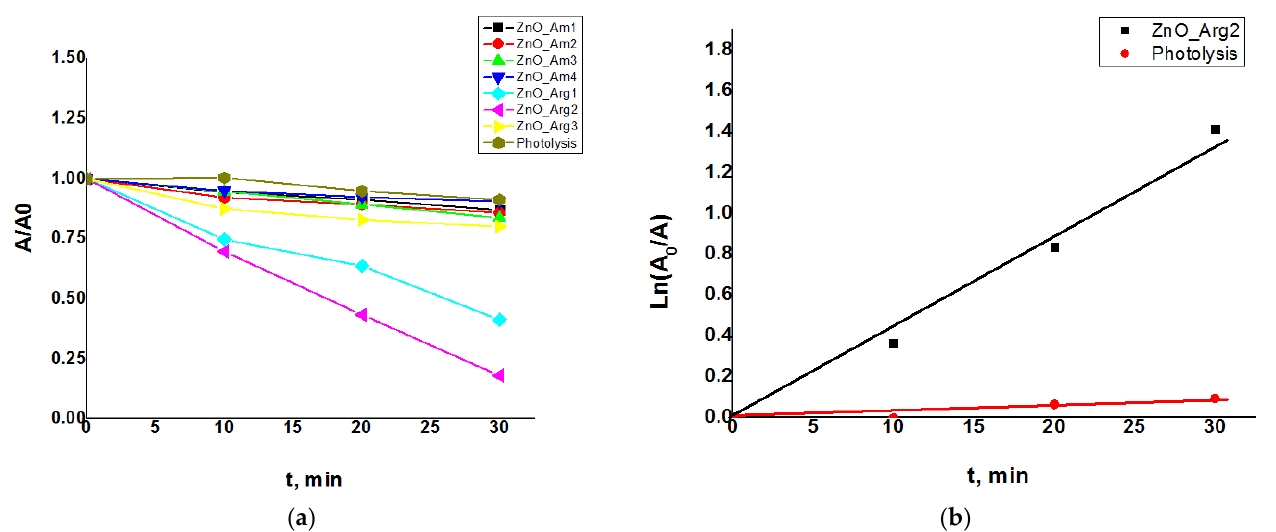
Figure 5. The discoloration curves of the MB with and without ZnO photocatalysts under UV irradiation. ( a ) Pseudo-first- order reaction kinetics in the absence of a catalyst and ( b ) in the presence of the ZnO_Arg2 sample.